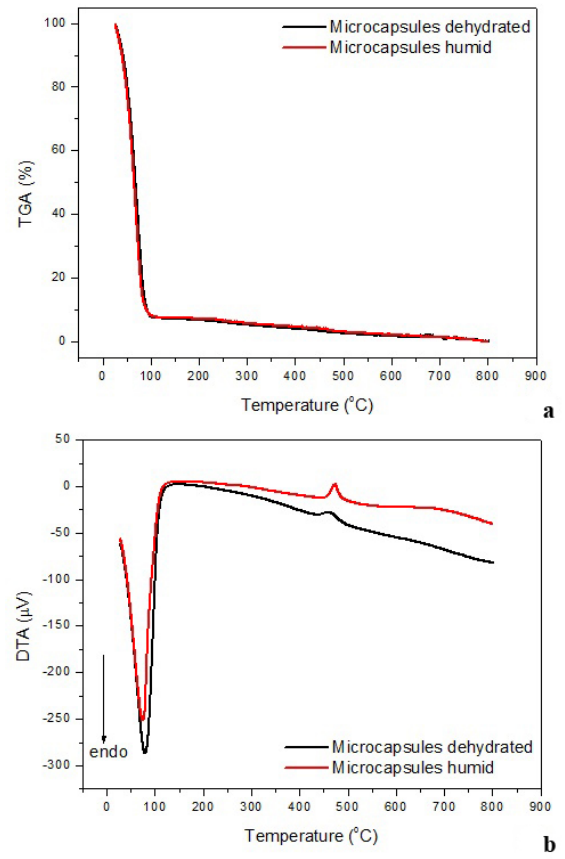
Figure 5 - TGA (a) and DTA (b) curves obtained for alginate/ gelatin microcapsules humid and